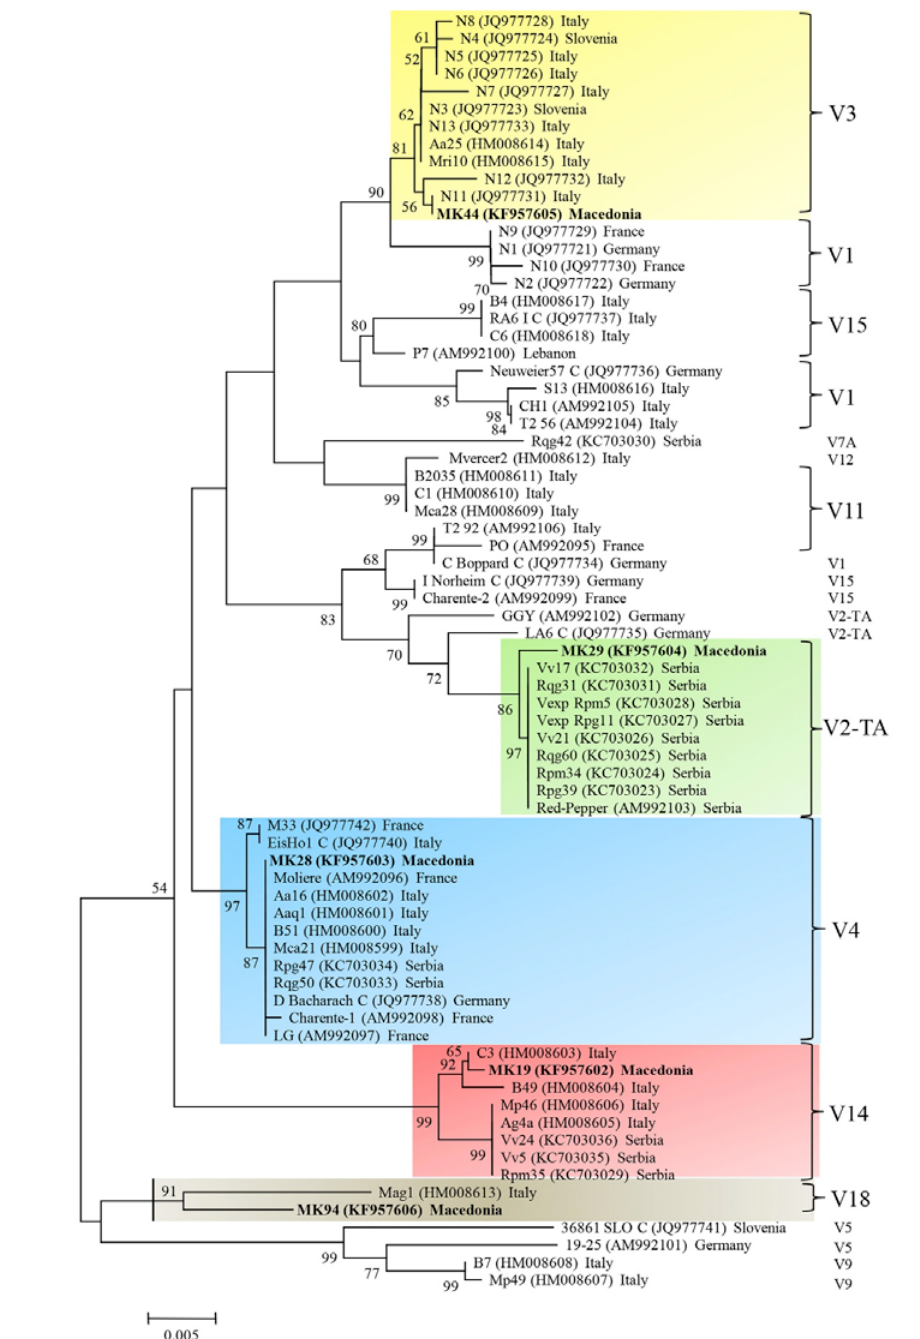
Figure 5. Unrooted phylogenetic tree inferred from ‘ Ca . P. solani’ strain nucleotide sequences of gene vmp1 . Minimum evolution analysis was carried out using the neighbor-joining method and bootstrap replicated 1,000 times. Names of phytoplasma strains included in phylogenetic analysis are written on the tree image. GenBank accession number of each sequence is given in parenthesis; gene sequences obtained in the present study are indicated in bold characters. Clusters encompassing bois noir phytoplasmas from the present study are shown as colored